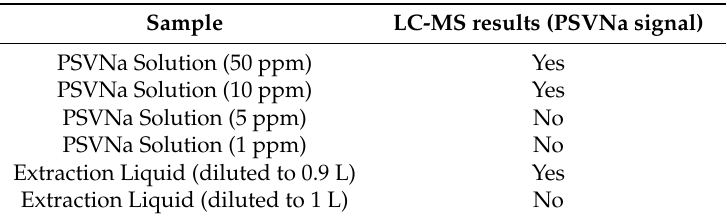
Table 2. Residue detection results of PSVNa.